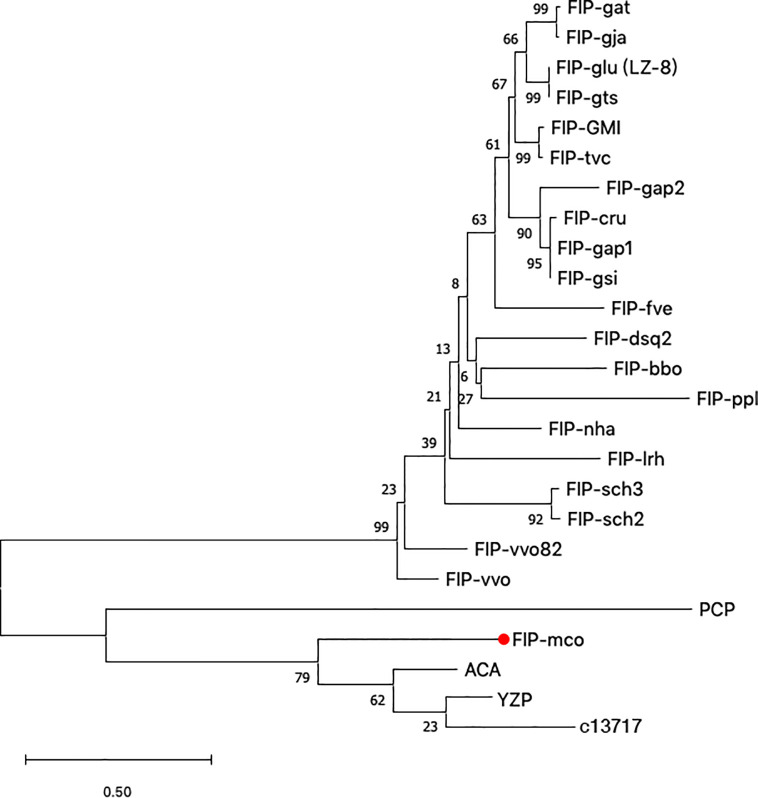
Phylogenetic tree based on protein sequences of selected FIPs. 24 amino acid sequences (Supplementary Table S1) were analyzed. The evolutionary relationship between FIPs were inferred using the Neighbor-Joining method, and Jones-Taylor-Thornton (JTT) model was used to compute evolutionary distances. The numbers at the nodes indicate bootstrap support values (%). The scale bar represents 0.5 substitutions per site.